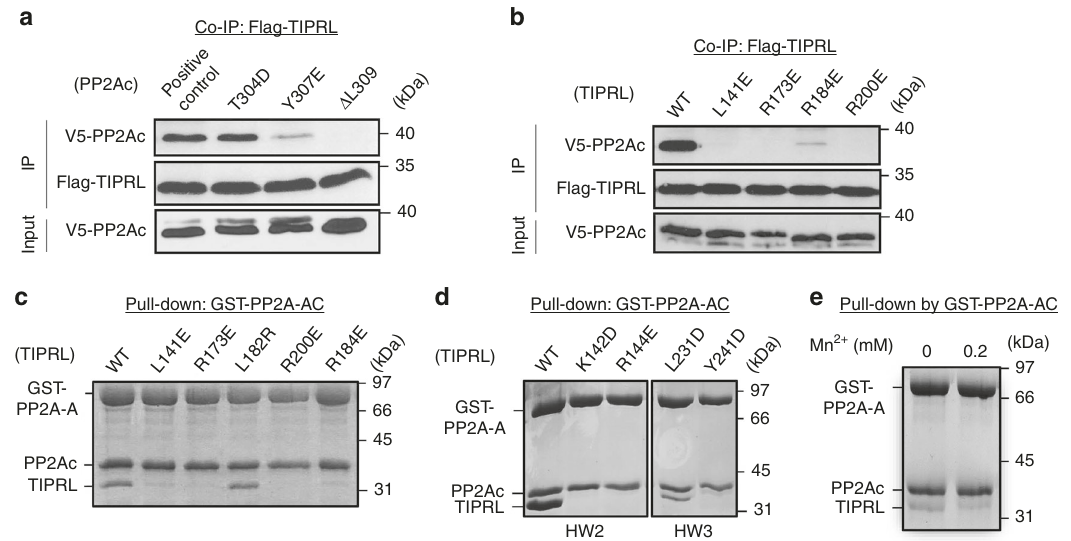
Fig. 3 Mutagenesis and biochemical characterization of PP2Ac – TIPRL interfaces and their modes of interaction. a Co-IP of WT and mutant V5-tagged PP2Ac bearing mutations in PP2Ac tail by Flag-tagged TIPRL. b Co-IP of V5-tagged PP2Ac by WT and mutant Flag-tagged TIPRL bearing mutations at the interface to PP2Ac tail shown in Fig. 2b. c Pulldown of WT and mutant TIPRL bearing mutations on residues involving in interaction with PP2Ac tail by PP2A core enzyme containing GST-PP2A-A. d Pulldown of WT and mutant TIPRL bearing mutations at the interface to structural elements near the PP2A active site by GST-PP2A core enzyme as in c . e Pulldown of TIPRL by GST-PP2A core enzyme in the presence or absence of Mn 2+ . For c – e , proteins remained bound to GS4B resin were examined on